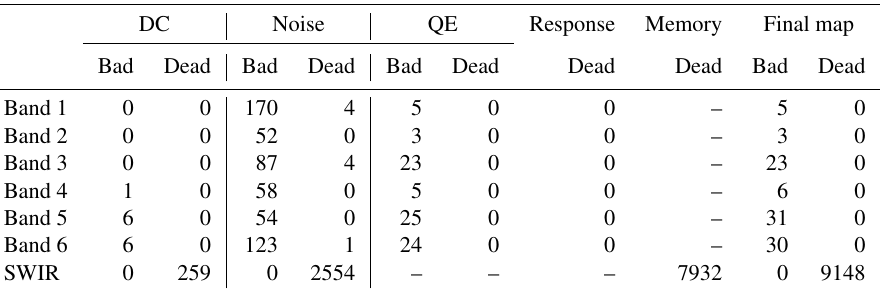
Table 4. Number of bad and dead pixels per band, due to increased dark current (DC), increased darkness noise (not included in final map), decreased quantum efficiency (QE), or missing